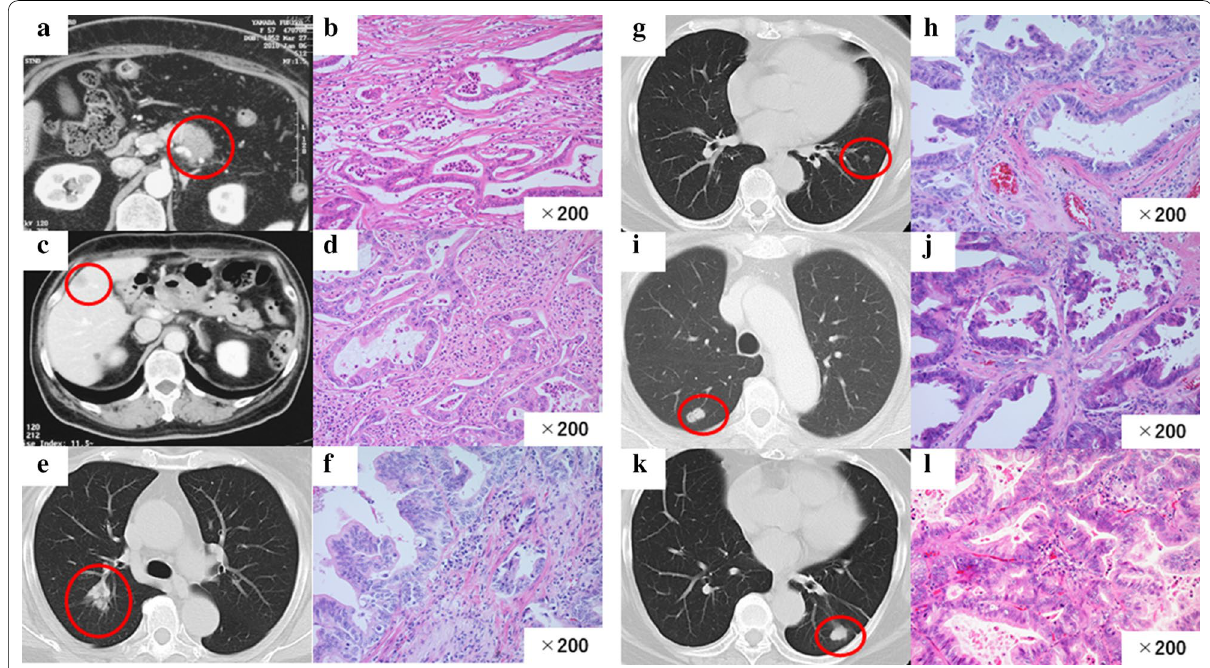
Fig. 1 a CT image showing a 3.0 cm hypovascular tumor in the pancreatic body. b Photomicrograph showing cancer cells with abundant fibrosis are arranged as tubular structures (hematoxylin and eosin [HE] staining). Original magnification: 200. c CT image showing a mass suggestive of × metastasis in the liver (S5). d Photomicrograph showing cancer cells with abundant fibrosis that are similar to those of the original pancreatic cancer (HE staining). Original magnification: 200. e CT image showing a nodule in the right lung (S2). F. Photomicrograph showing the tumor is similar × to the original pancreatic cancer (HE staining). Original magnification: 200. g CT image showing a nodule in the left lung (S9). h Photomicrograph × showing the tumor is similar to the original pancreatic cancer (HE staining). Original magnification: 200. i. CT image showing a nodule in the right × lung (S6). j Photomicrograph showing a tumor that was diagnosed as metastatic pancreatic cancer (HE staining). Original magnification: 200. × k CT image showing a nodule in the left lung (S6). l Photomicrograph showing a tumor that was diagnosed as metastatic pancreatic cancer